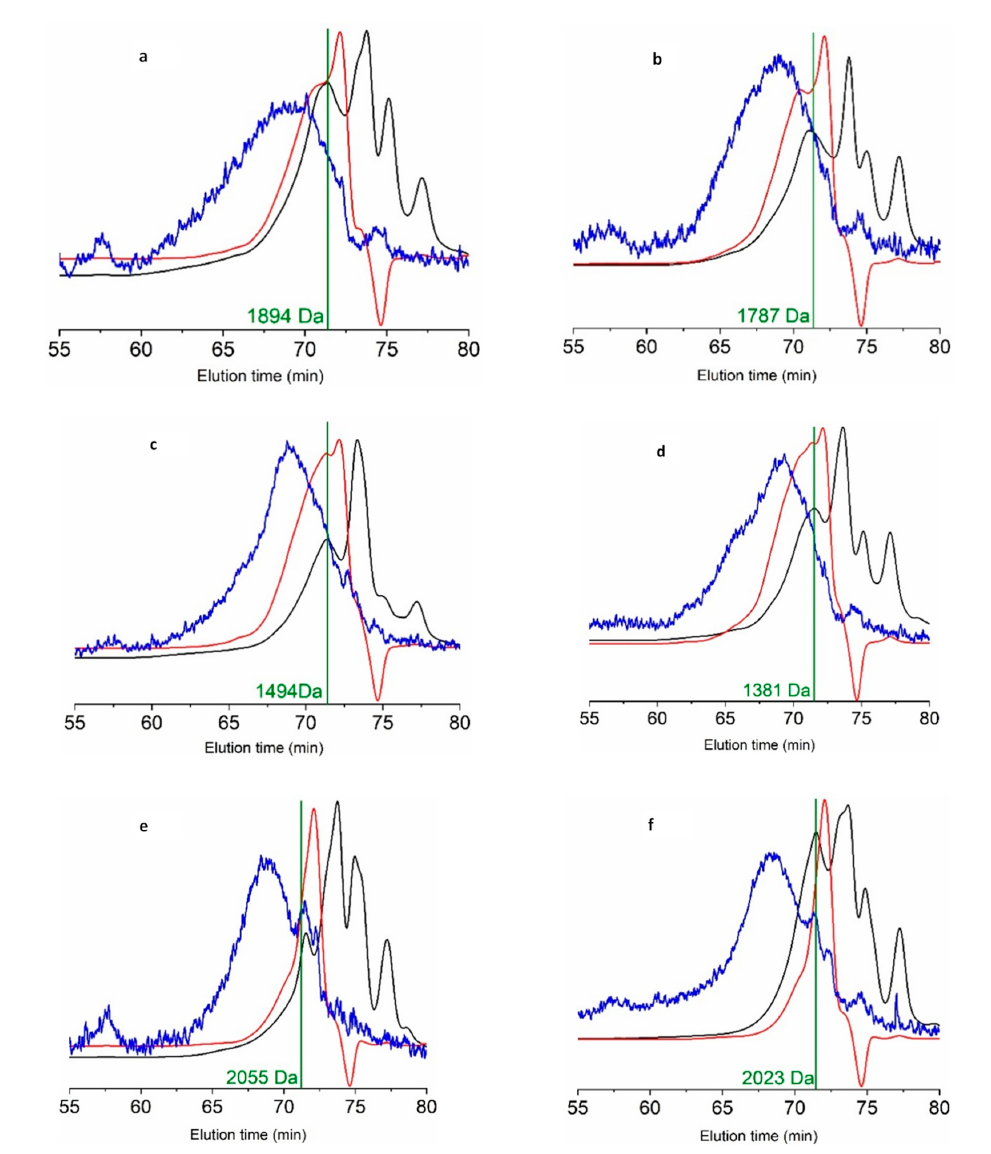
Figure 4. GPC eluograms of hydrolysates of heads ( a , b ), frames and trimmings ( c , d ) and viscera ( e , f ) of seabream ( a , c , e ) and seabass ( b , d , f ). Red line: refractive index; black line: UV (280 nm); blue line: right angle light scattering; vertical lines: weight average molecular weight (Mw).